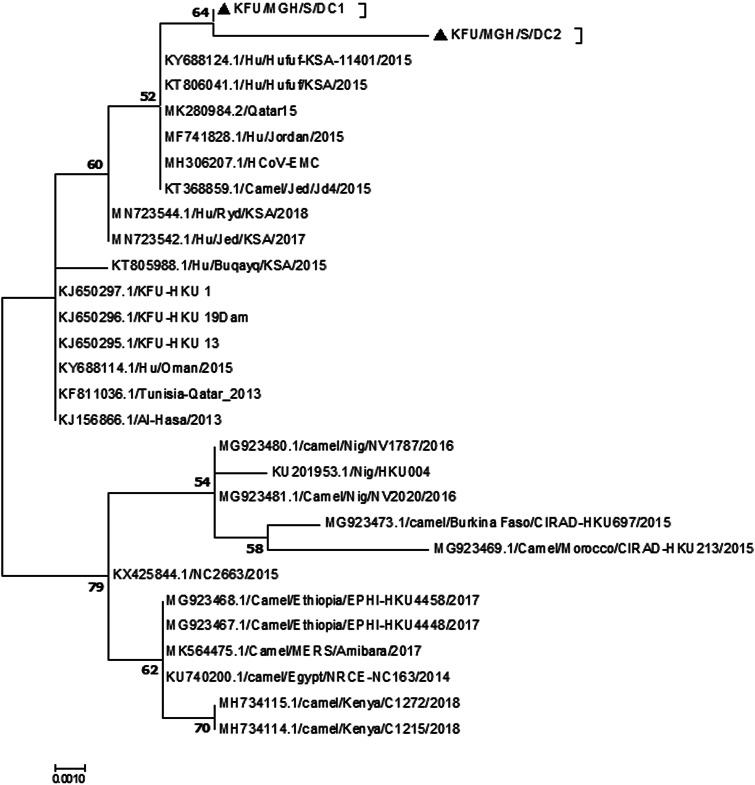
Phylogenetic analysis based on the partial MERS-CoV-S gene. Phylogenetic analysis based on the partial MERS-CoV-S gene from doves and dromedary camels shared the habitat. The maximum likelihood based on the partial MERS-CoV-S sequences revealed these sequences clustered together and share a high degree of identity with other sequences reported from eastern Saudi Arabia, Qatar and Jordon reported in 2015. Our sequences are identified with black triangles.